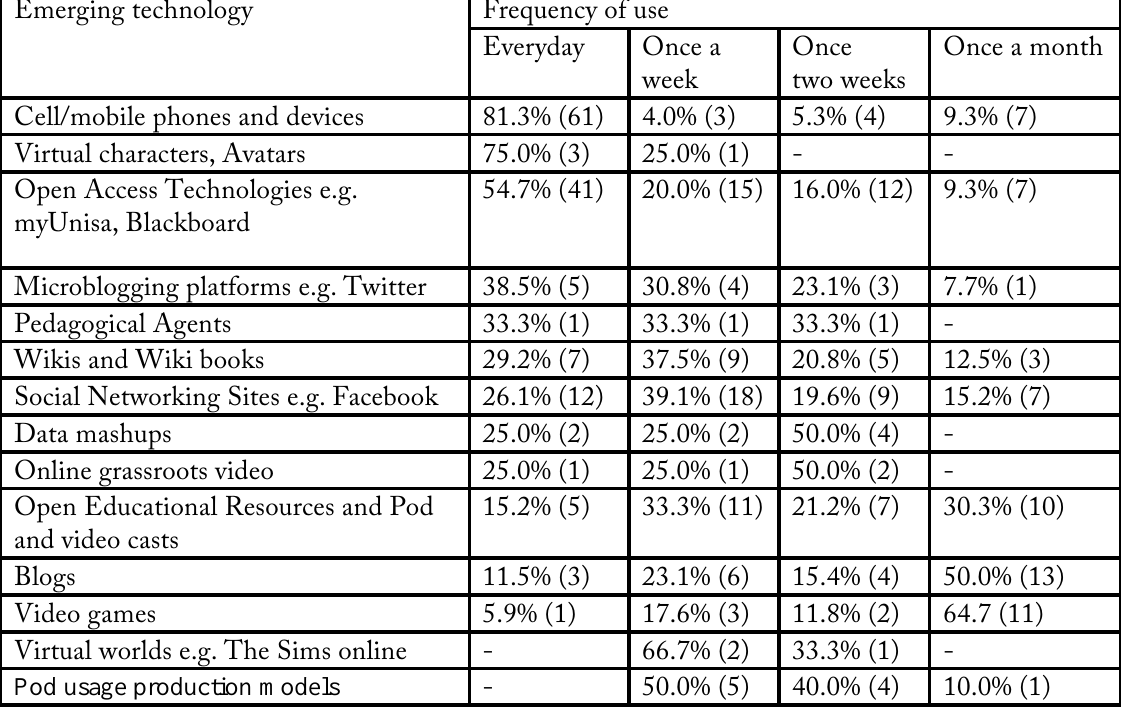
Table7: Frequency of usage of emerging e-learning technology Emerging